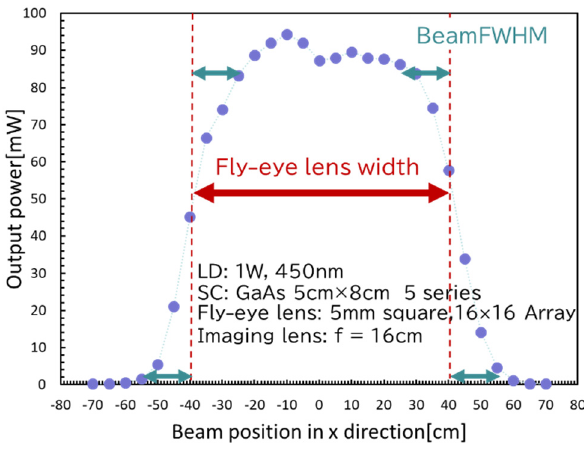
Figure 4. Beam position dependence of the output power.